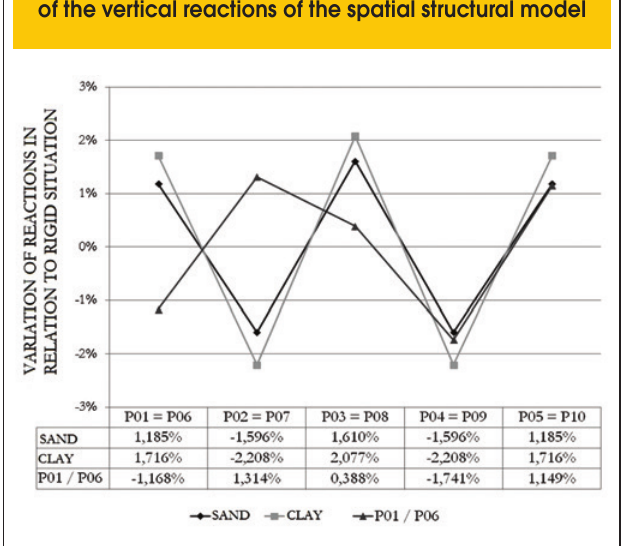
Figure 5.3 – Axial Effort variation for the vertical line P01-P21